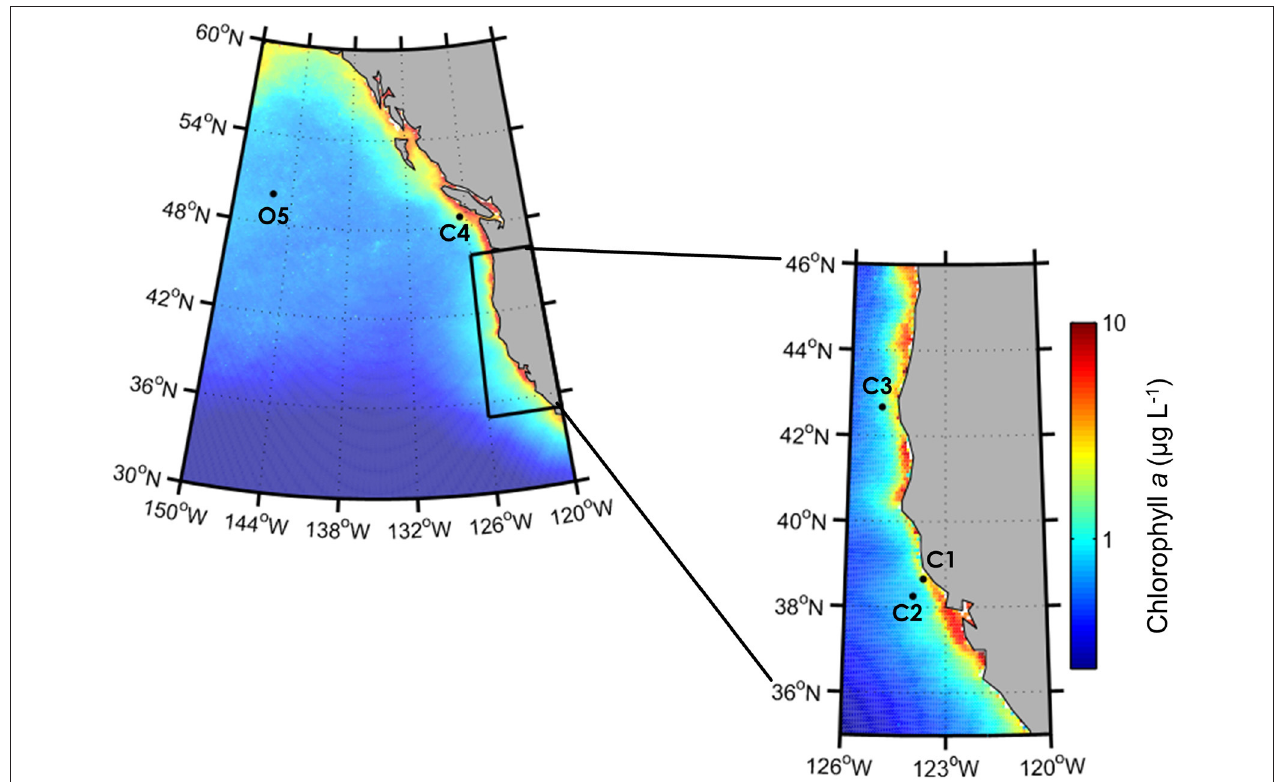
FIGURE 1 | Locations of incubation experiments in the California Upwelling Zone (C1, C2, C3) and along Line P (C4, O5) in the Northeast Pacific Ocean. Color bar indicates climatological-averaged chlorophyll a concentrations ( µ g L − 1 ) from SeaWiFS